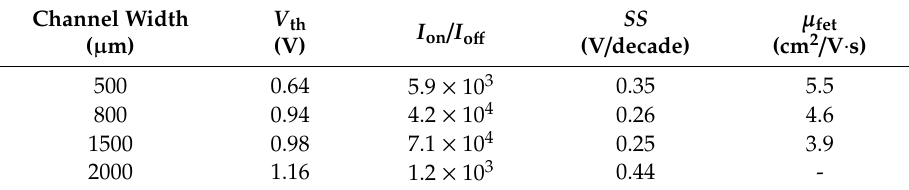
Table 5. The electrical performance parameters of a -IGZO TFT with di ff erent sizes of channel width at an oxygen flow rate of 6